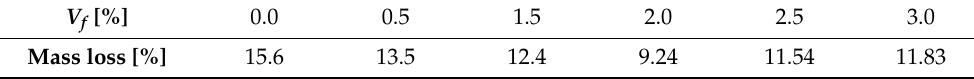
Table 5. Percentage of mass loss of rebar due to corrosion for PC and GFRC [27]. V f [%]